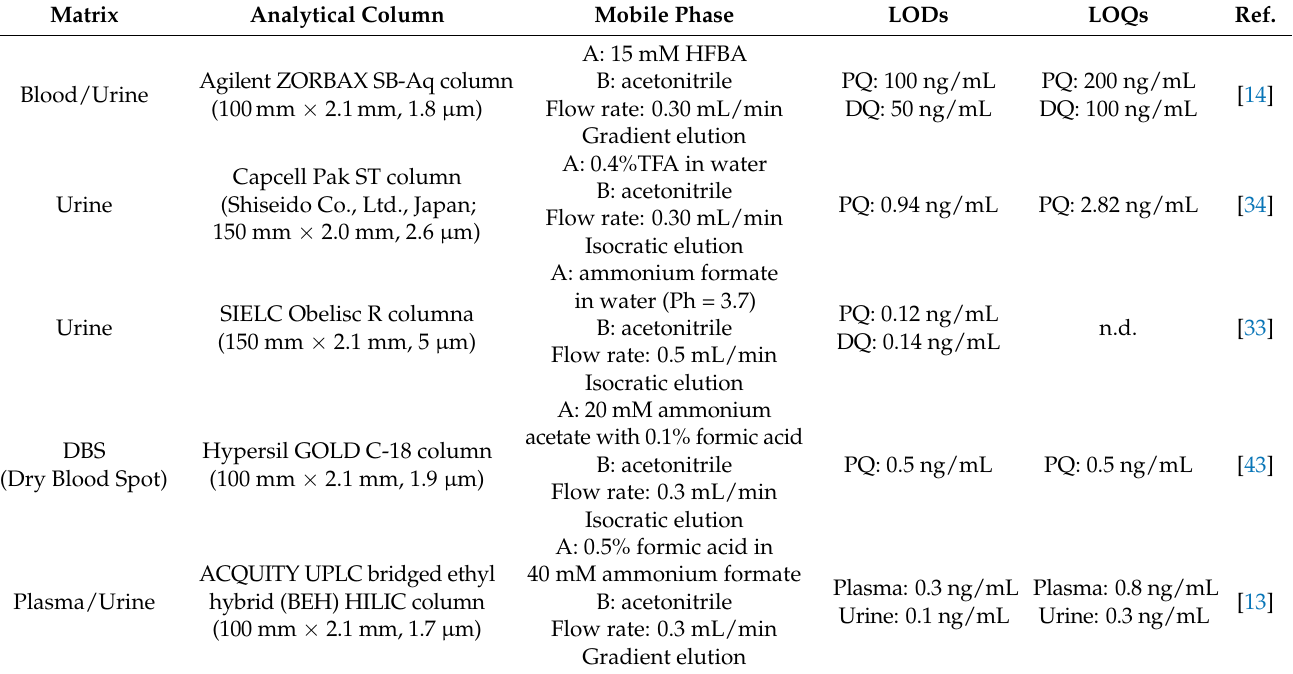
Table 2. Examples of LC–MS and LC–MS/MS methods for the detection of PQ and DQ. Matrix Analytical Column Mobile Phase